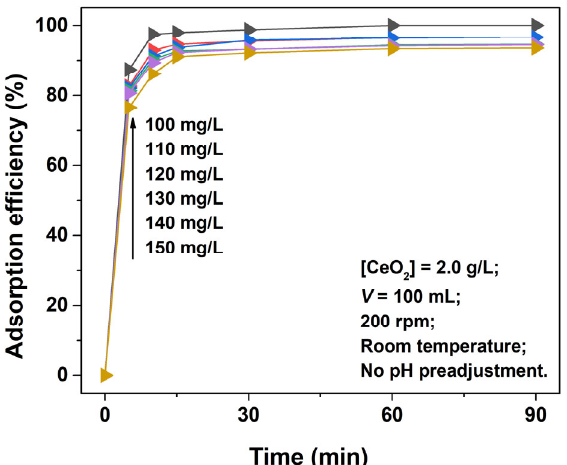
Figure 7. Time − dependence of the adsorption profiles of AO7 dye obtained at varying initial concentrations (100~150 mg/L) in the presence of porous CeO 2 adsorbent hydrothermally synthesized at 200 °C for 24 h with 4 mmol guanidine carbonate and 4 mL 30% H 2 O 2 .